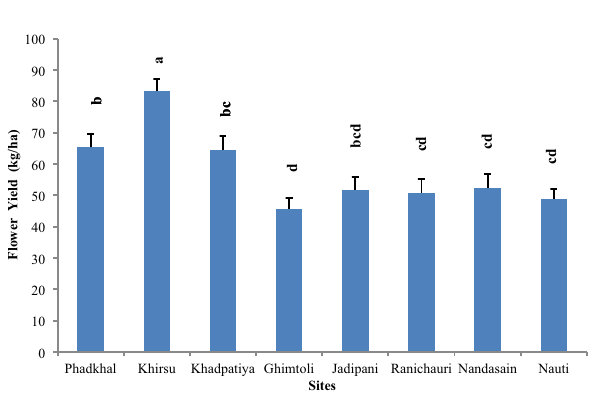
Figure 3. Mean flower yield (kg/ha) on R. arboreum trees across sites in Garhwal region. Bar with different letter indicate significant difference (Kruskal–Wallis test; H = 57.37, df = 7, p < 0.001).